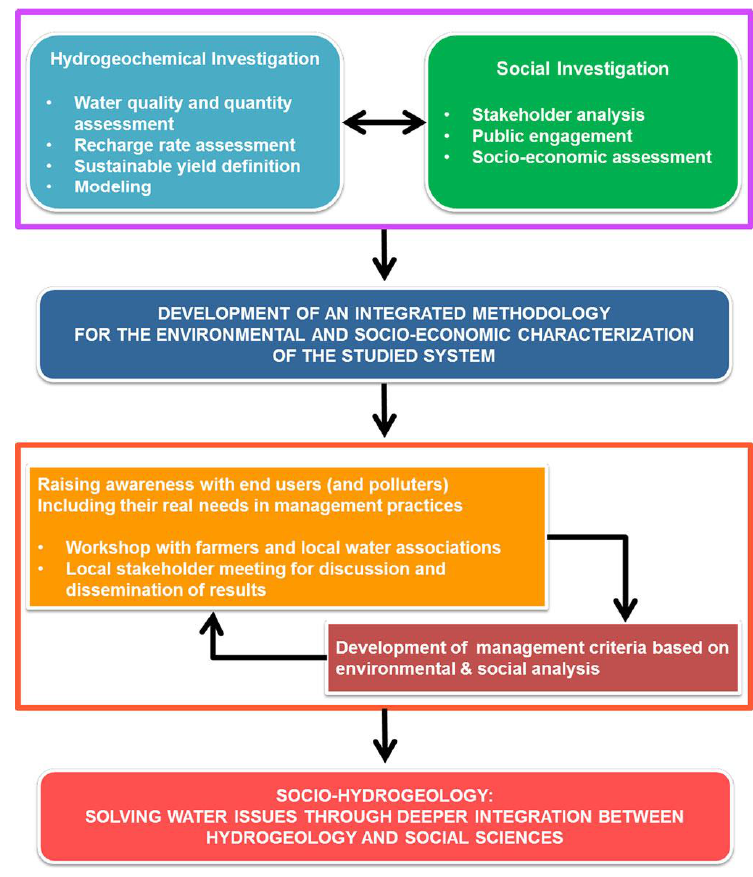
Figure 2. Schematic description of the bottom-up integrated approach for sustainable groundwater management in rural areas (Bir Al-Nas) approach for socio-hydrogeology (Re, 2015).